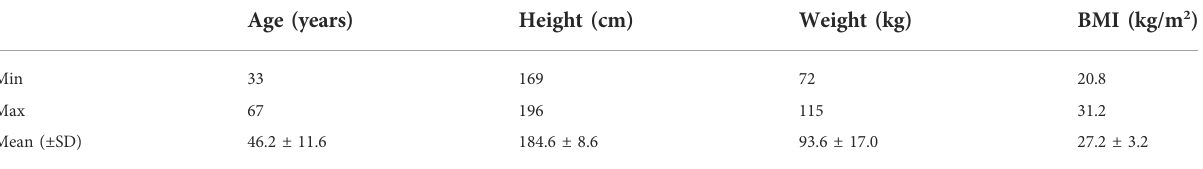
TABLE 1 Anthropometric data for the 11 study subjects.